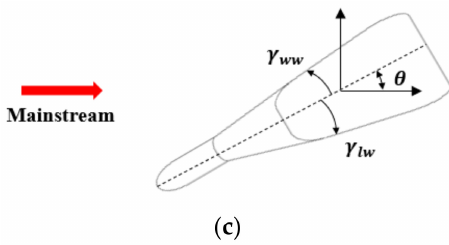
Figure 1. Geometry of the compound angled asymmetric laidback fan shaped hole: ( a ) laidback fan shaped hole; ( b ) simple angled symmetric laidback fan shaped hole; ( c ) compound angled asymmetric laidback fan shaped